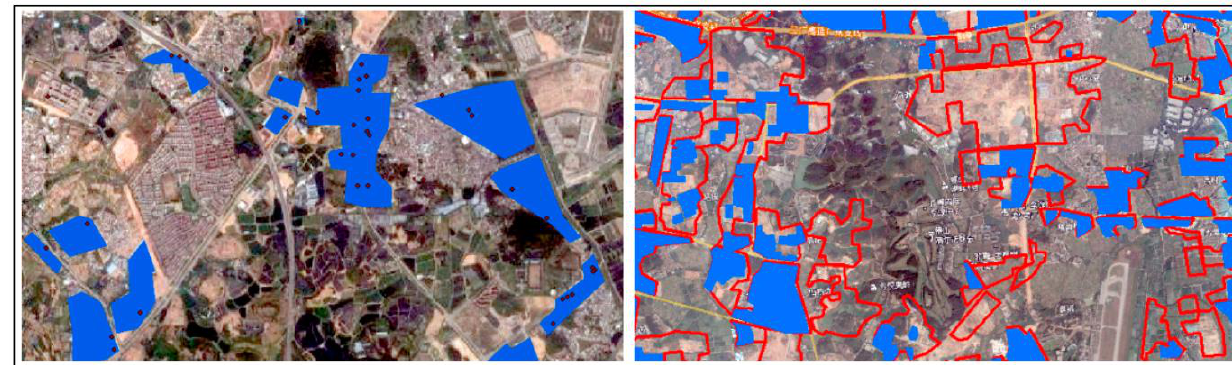
Figure 3. Interpretation of manufacturing production spaces vector in the historical period.